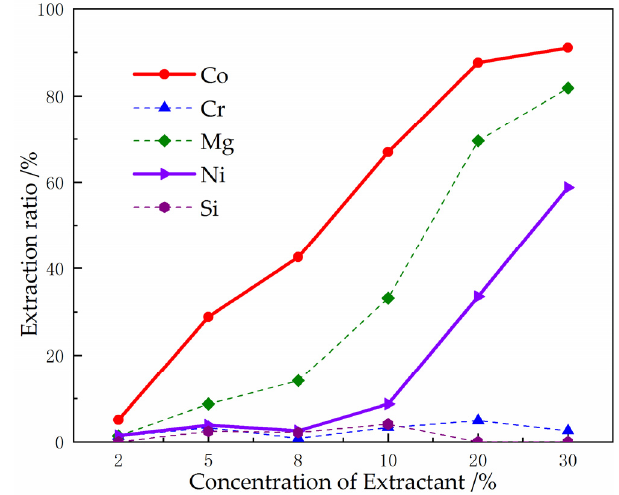
Figure 11. E ff ect of P507 concentration on extraction of metal Figure 11. Effect of P507 concentration on extraction of metal ions. Table 5. Extraction ratios of different ions %.